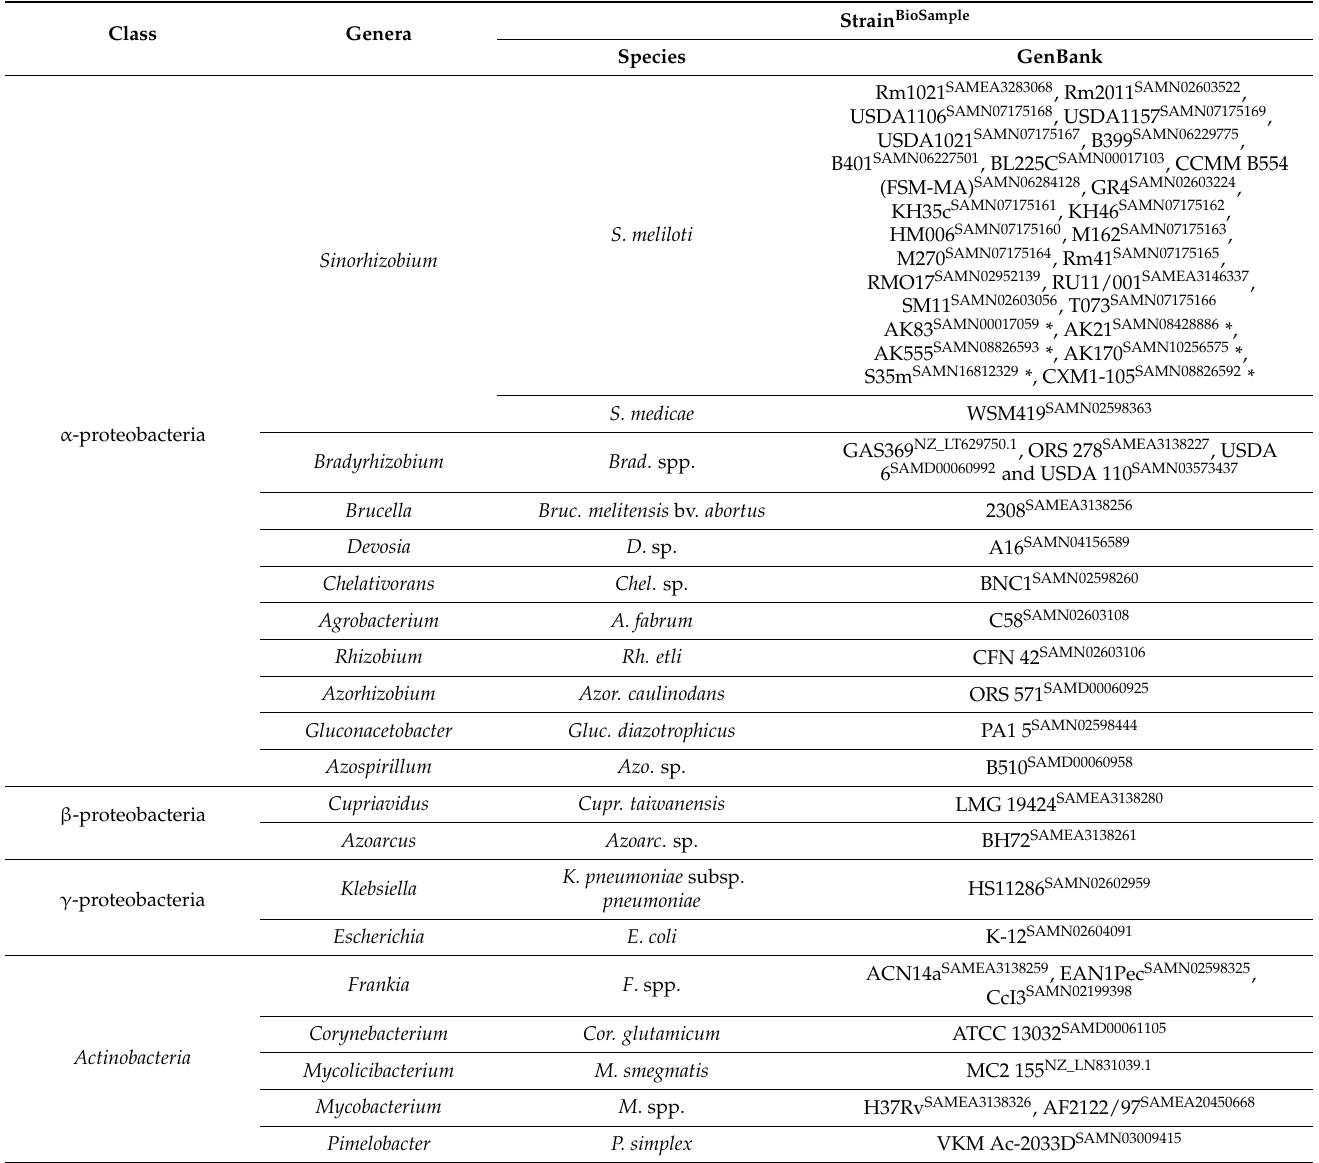
Table 1. List of bacterial